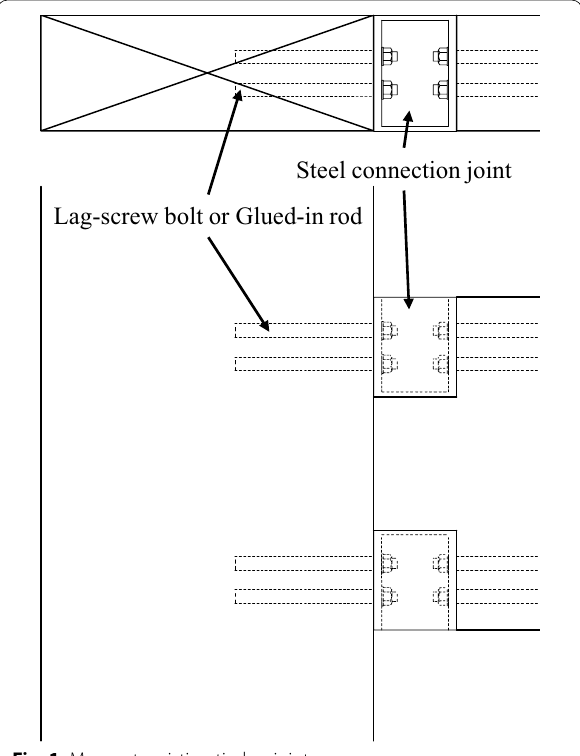
Fig. 1 Moment-resisting timber joint